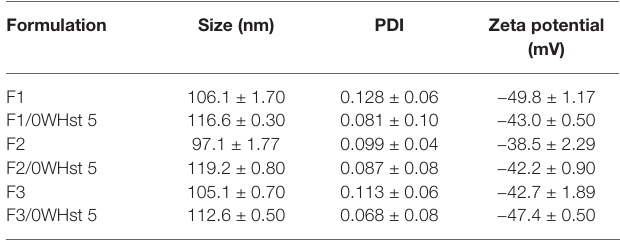
TABLE 3 | Size, PDI, and zeta potential for empty and loaded F1, F2, and F3 liposomes, obtained by extrusion. Formulation